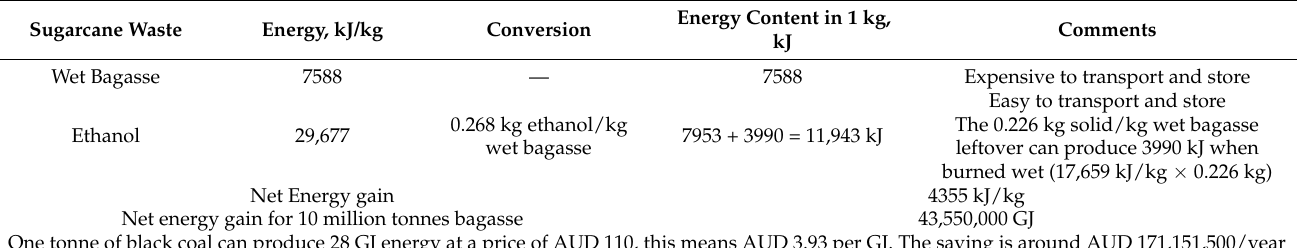
Table 11. Energy production from wet bagasse compared to bagasse-based ethanol.